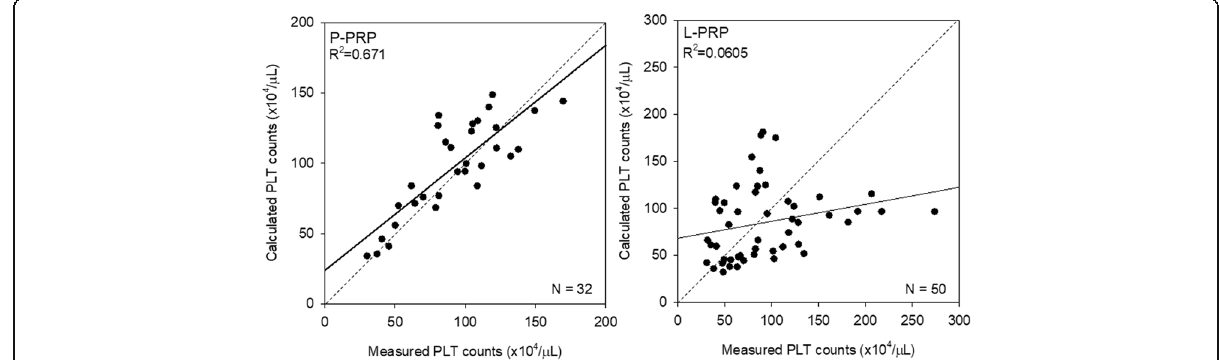
Fig. 7 Scatter plots representing correlations between measured and calculated platelet counts in P-PRP and L-PRP preparations. Note: a strong correlation was observed only in P-PRP. N = 32 and 50 for P-PRP and L-PRP,